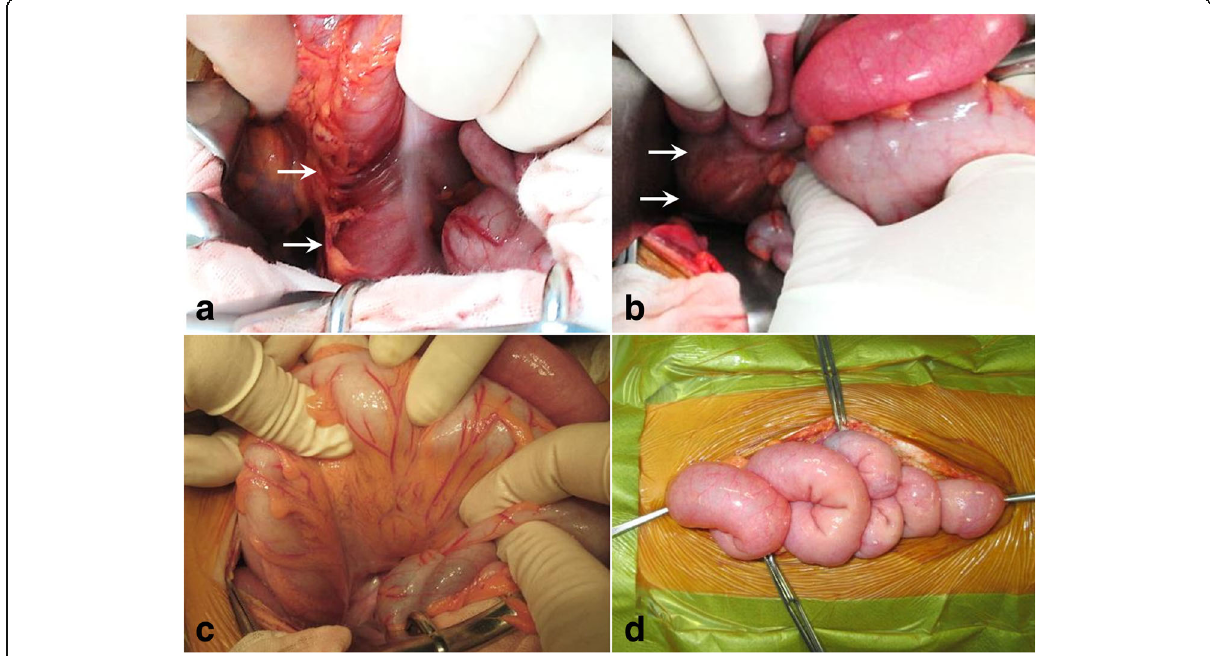
Fig. 2 Operative findings. There were skip ischemic lesions (arrow) in the ascending colon ( a ) and the rectum ( b ) without bowel perforation. The remaining colon, from the transverse to the sigmoid colon, appeared intact ( c ). Bowel color and peristalsis were restored in the small bowel ( d )